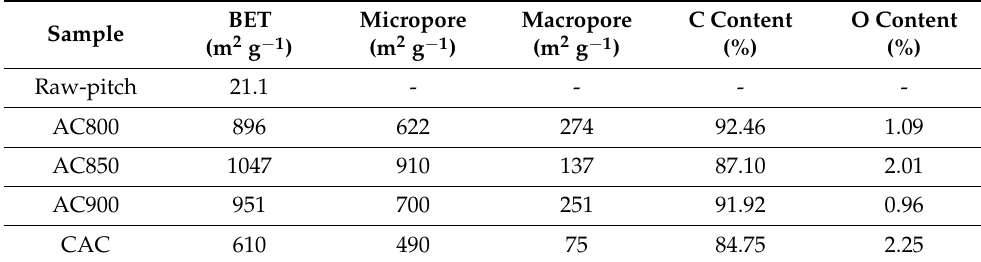
Table 2. The physical and chemical surface of samples.